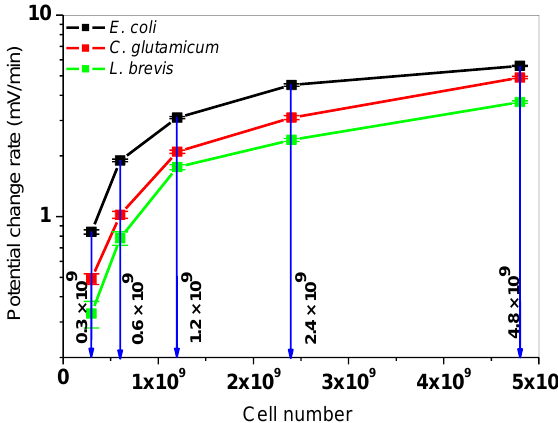
Figure 5. Correlation between the LAPS signal response and the cell number. The mean values and standard deviations of PCR values of E. coli (black), C. glutamicum (red), and L. brevis (green) are depicted for different cell numbers (0.3 × 10 9 , 0.6 × 10 9 , 1.2 × 10 9 , 2.4 × 10 9 , 4.8 × 10 9 cells) at a constant glucose concentration of 1.67 mM. Three independent measurement repetitions were performed.